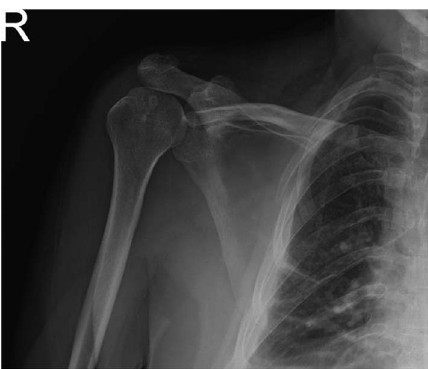
Figure 1. AP radiographs of the right shoulder 8 weeks after injury demonstrating subcoracoid dislocation of the distal clavicle.